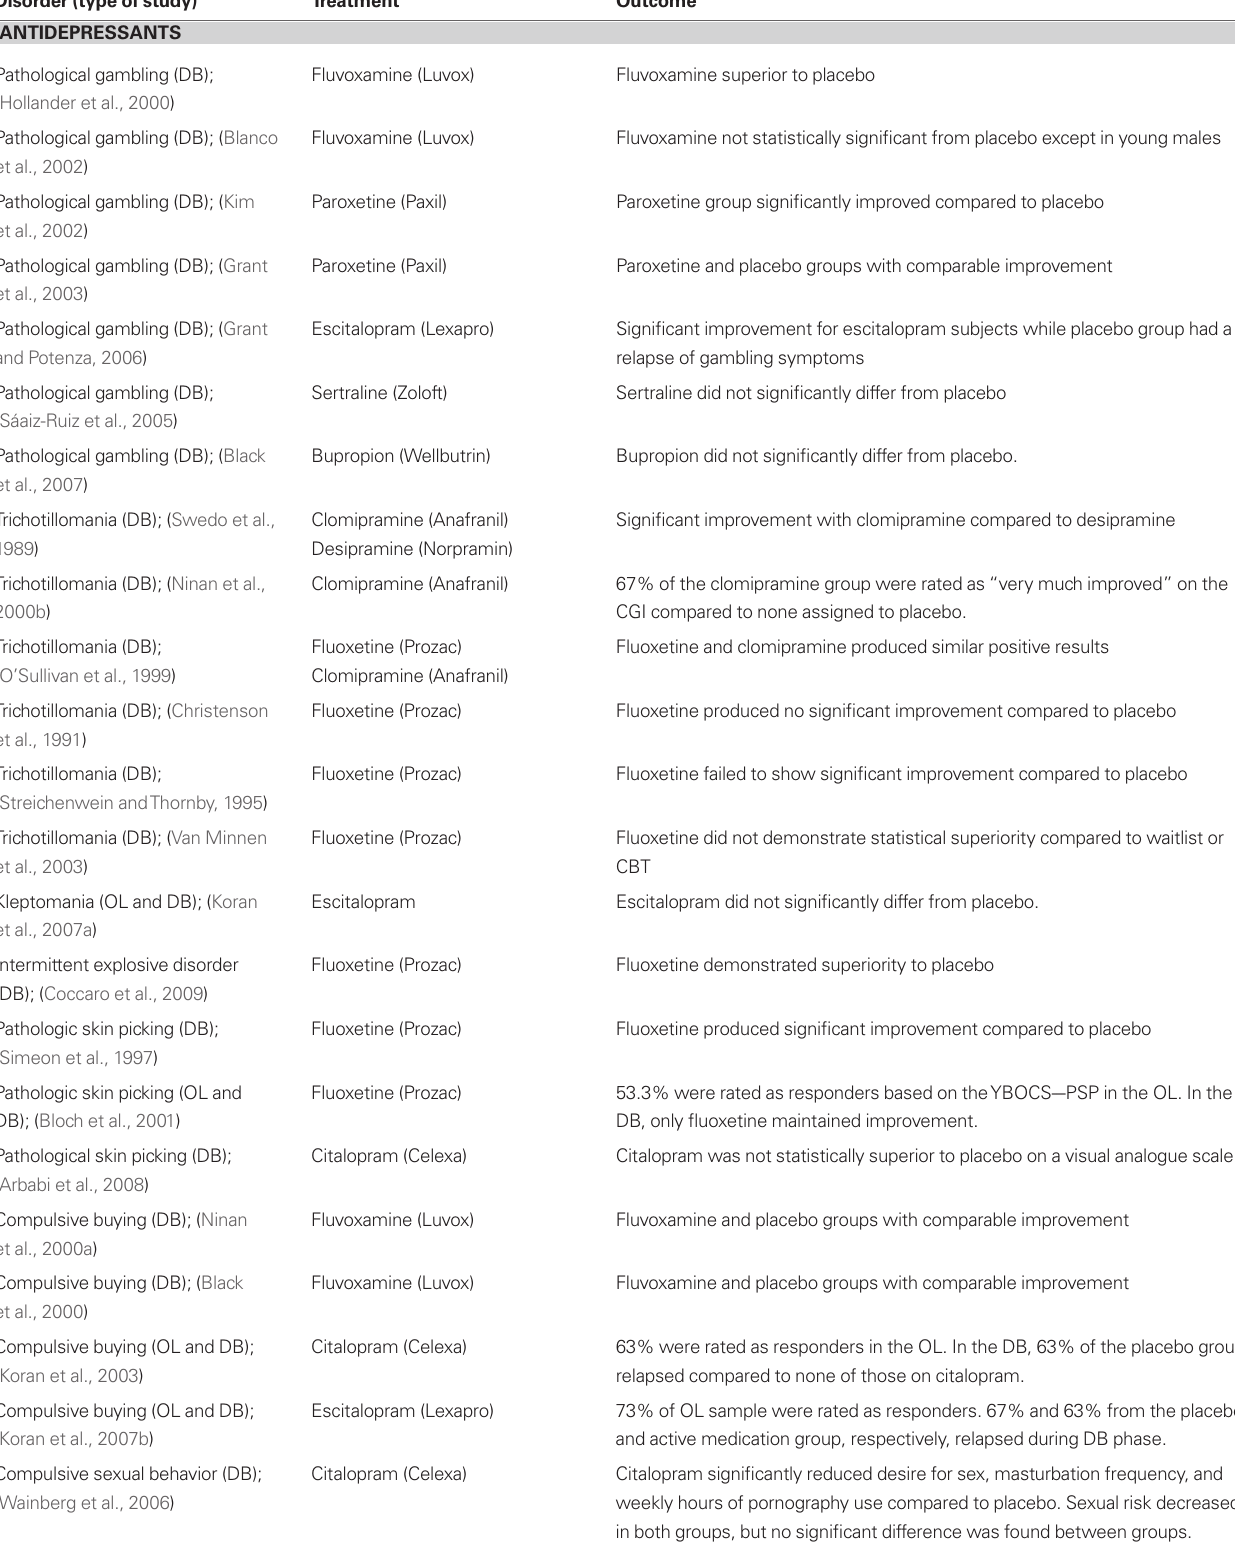
Table 1 | Double-blind placebo-controlled pharmacological treatment studies of impulse control disorders. Disorder (type of